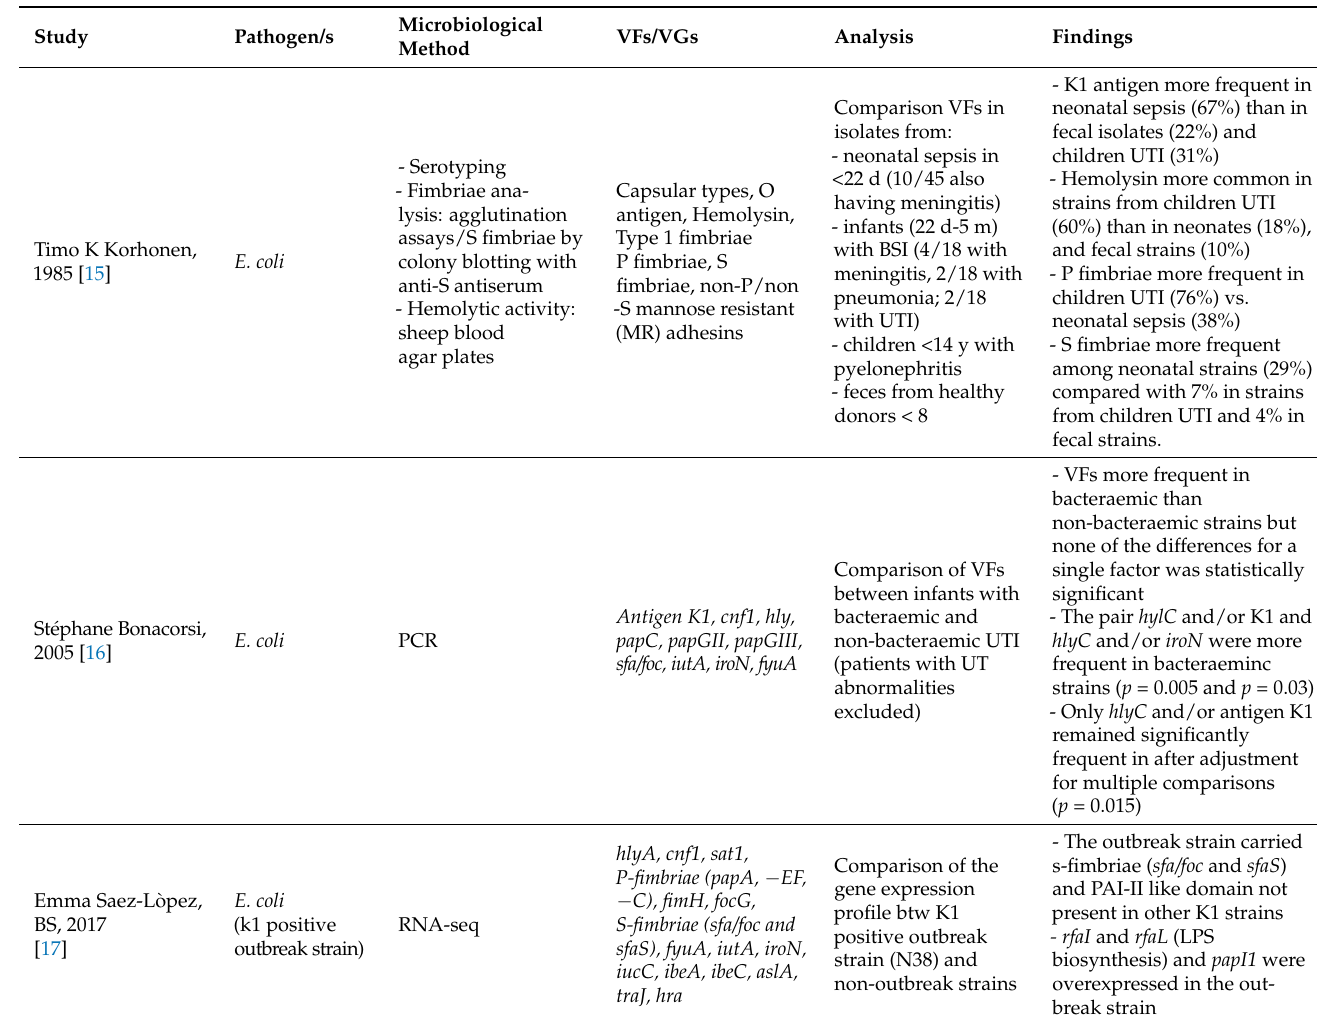
Table 2. Comparison between bacteraemic strains vs. other strains (non-invasive infections, faecal flora, environmental